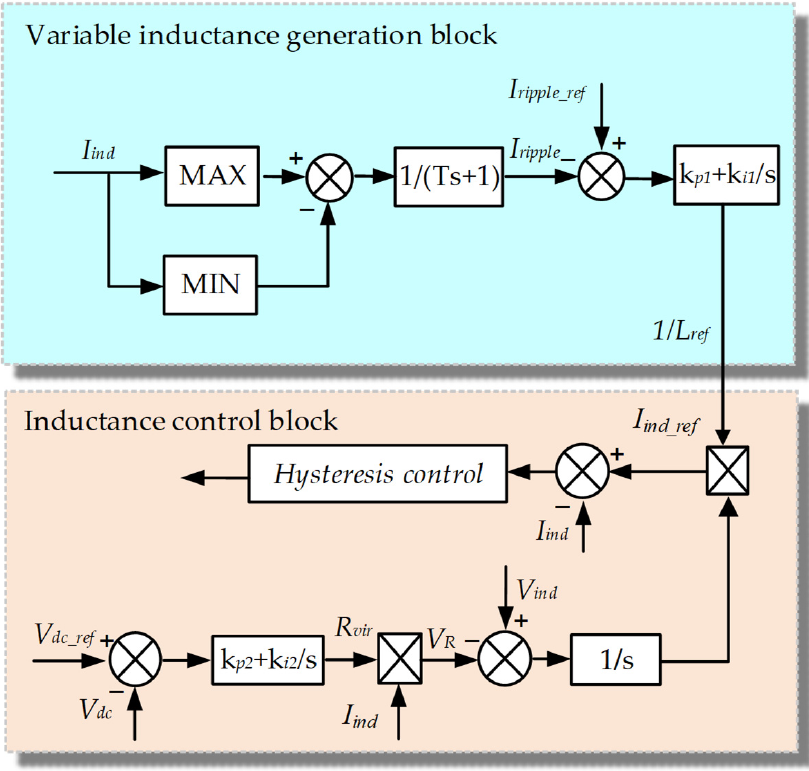
Figure 4. Control diagram of the variable active inductor.